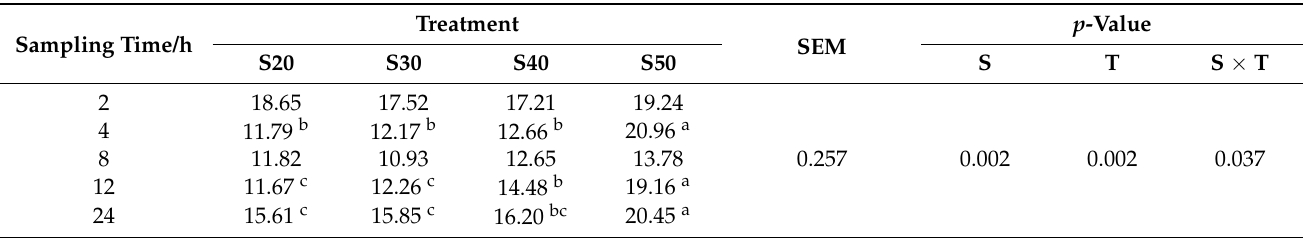
Table 3. The effect of substrate SP (% of CP) levels on NH 3 -N content at different sampling times in vitro (mg/100 mL).